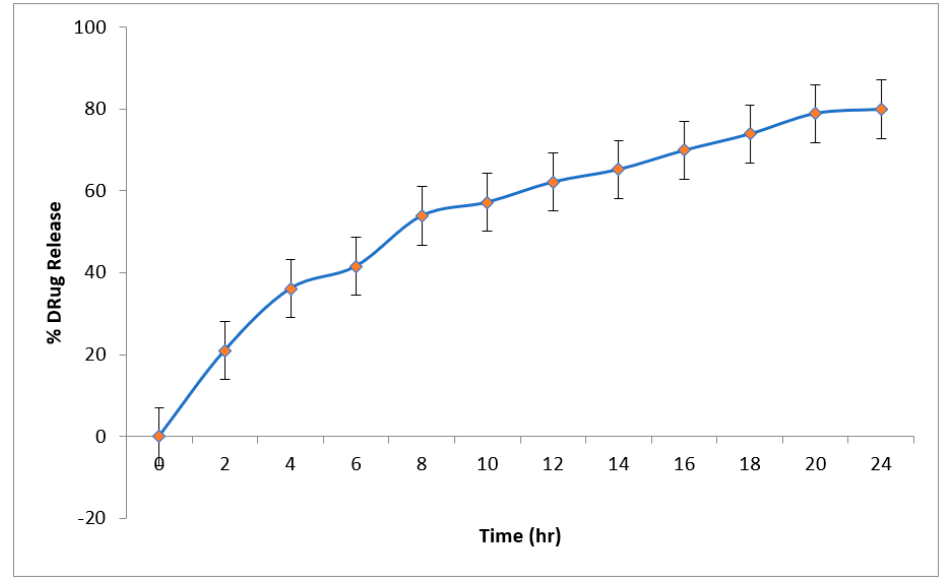
Figure 6. Drug release of hesperidin-loaded lipid polymer hybrid nanoparticles.